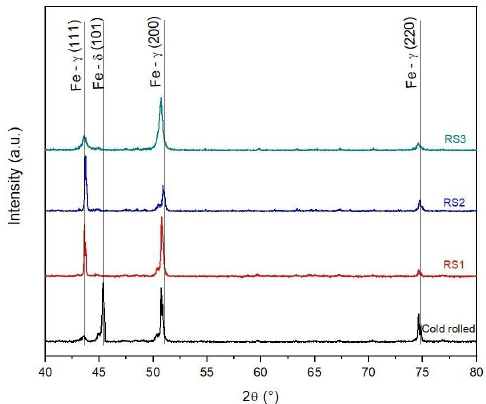
Figure 7. X-ray diffraction spectra of the 316L stainless steel under cold rolling conditions in the direction ND and rapid solidification (regions: RS1, RS2 and RS3).